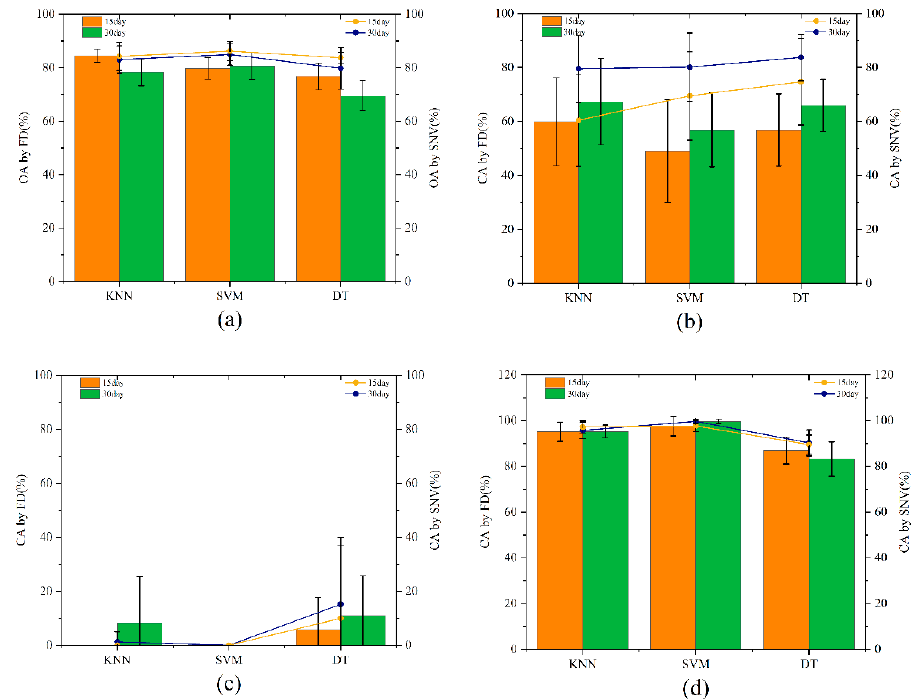
Figure 2. OA ( a ) and CA ( b – d ) modeled based on SPA.